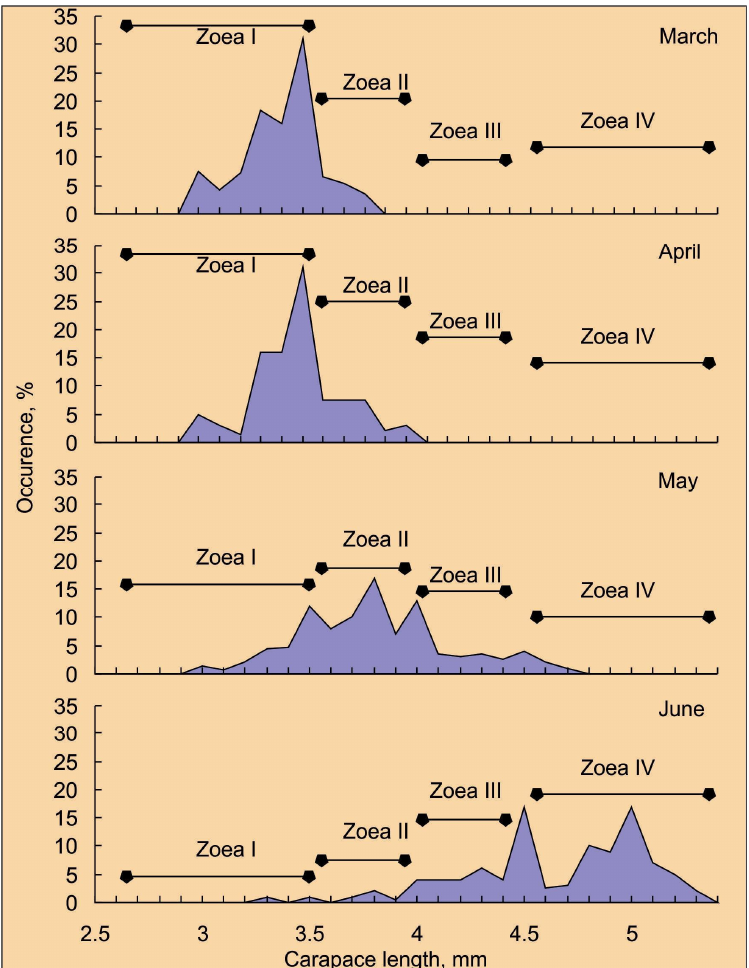
Figure 5. Occurrence of red king crab larvae and their size structure in Russian waters of the Barents Sea (spring 1996–1999, Ura Bay) (modified from [79]).